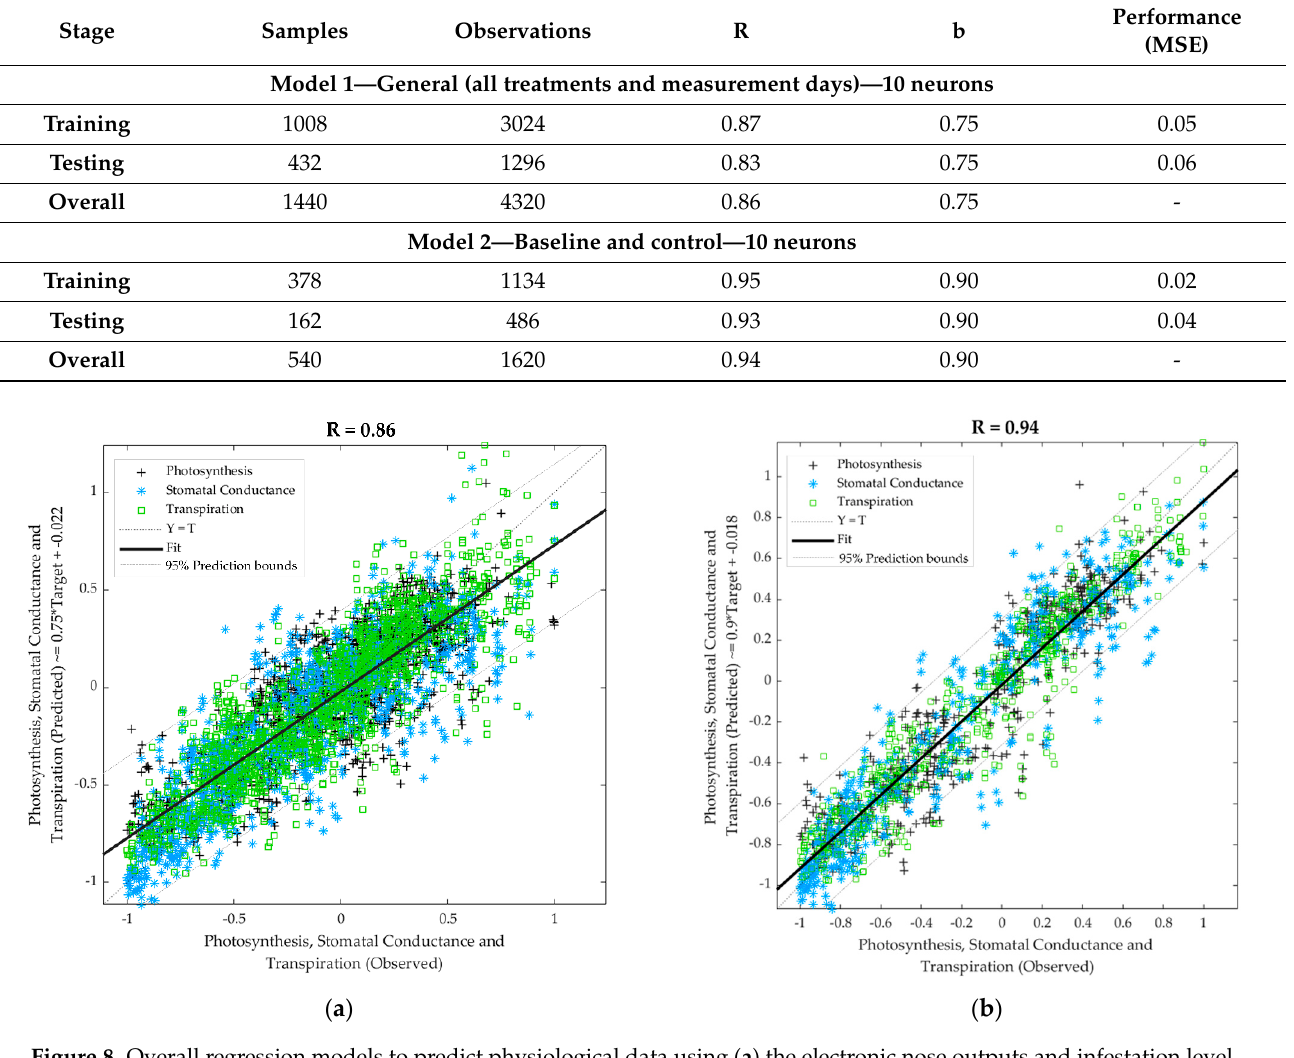
Figure 8. Overall regression models to predict physiological data using ( a ) the electronic nose outputs and infestation level as inputs for general data using all treatments at all measurement days and ( b ) using the electronic nose outputs as inputs with the baseline and control data (non-infested). Abbreviations: R: correlation coefficient; T: targets.